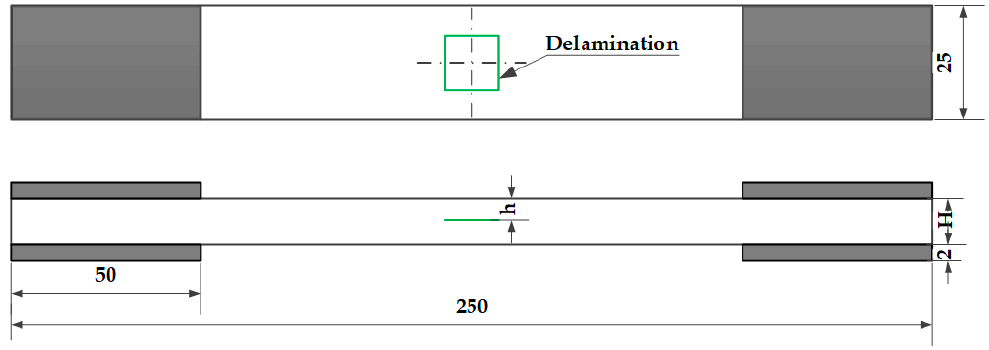
Figure 4. Schematic diagram of specimens with delamination.